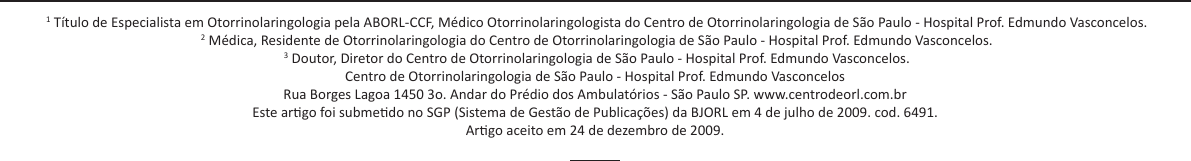
Figura 1. Sinuplastia em região de seio frontal direito. A: visão endoscópica (45 graus, 4mm) de meato médio direito e coloca- ção de cateter guia no seio frontal direito sob transiluminação. B: visão endoscópica (45 graus, 4 mm) da colocação do balão para dilatação do recesso e óstio do seio frontal direito. C: Visão endoscópica (45 graus, 4mm) do aspecto após a dilatação e lava- gem do seio frontal direito. D: Visão endoscópica (0 graus, 4mm) do meato médio direito ao final da sinuplastia. Note praticamente ausência total de trauma na mucosa